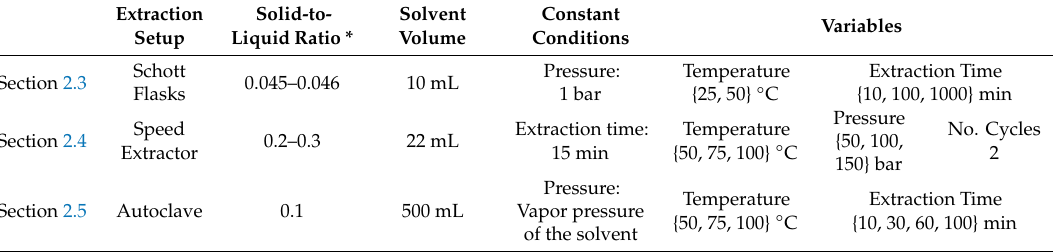
Table 1. Summary of the conditions, reaction volume, and variables of the performed